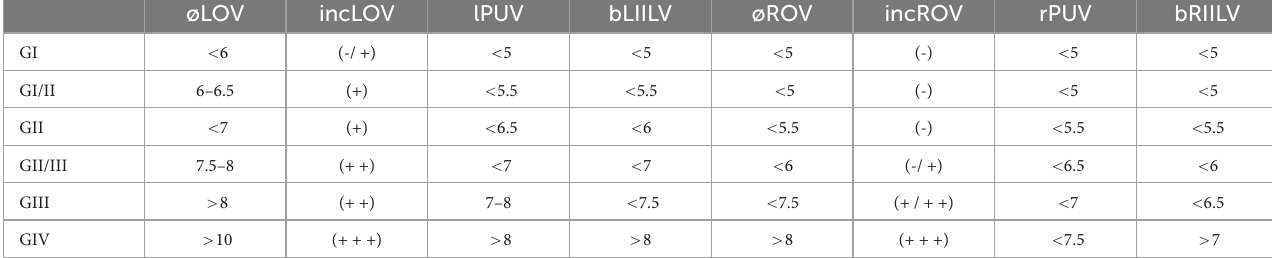
TABLE 4 Grading classification for ovarian veins system insufficiency proposed by Szary et al. (øLOV/øROV) left or right ovarian vein diameter (mm); (incLOV/incROV) left or right ovarian vein incompetence (+ or -); (lPUV/PUV) left or right para-uterine veins (mm); (bLIILV/bRILV) branches of left or right internal veins (mm).